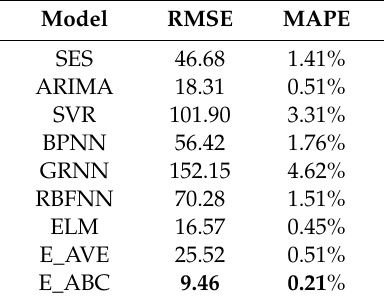
Table 4. Forecasting accuracy of all models.